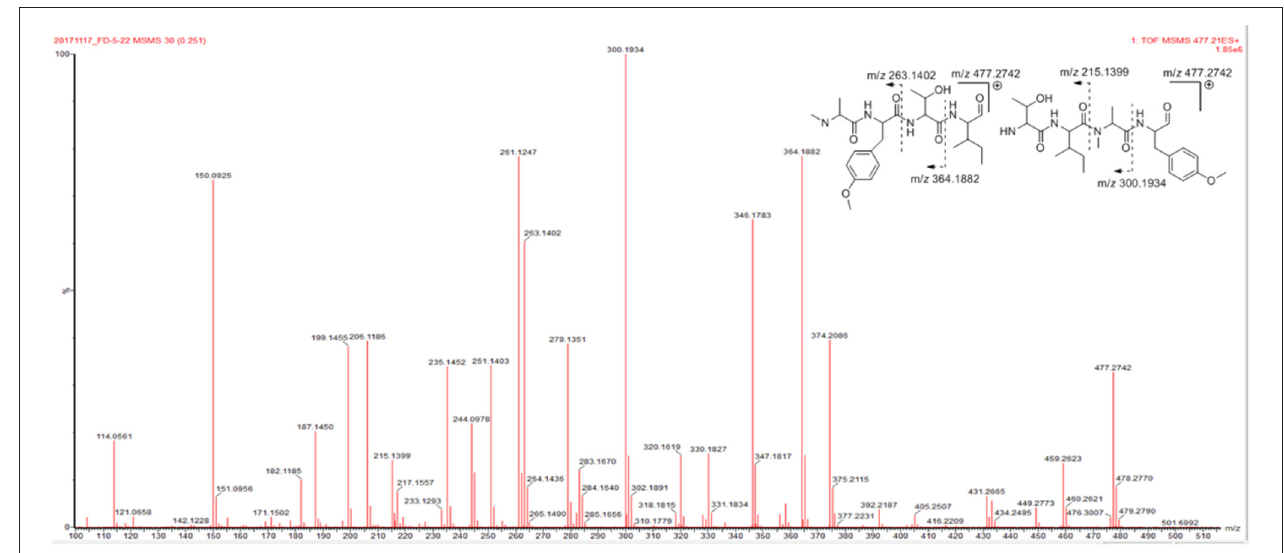
FIGURE 3 | MS/MS spectrum of 1